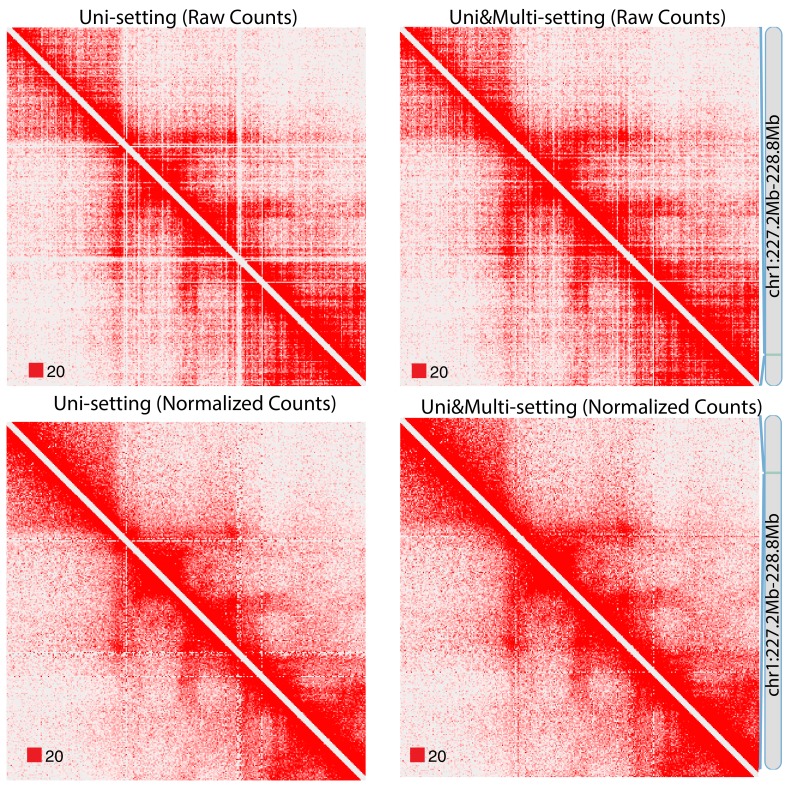
Raw and normalized contact matrices of GM12878 under Uni-setting and Uni&Multi-setting on chromosome 1.